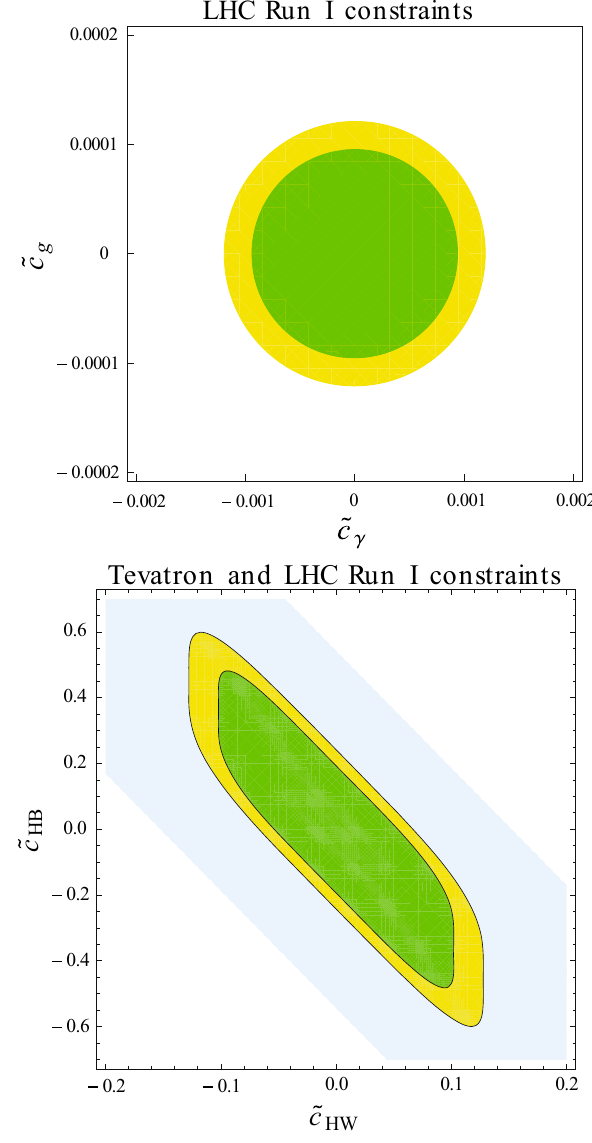
Fig. 2 Collider bounds on several of the effective operators consid- ered in the Lagrangian of Eq. (2). We show parameter space regions in agreement with LHC Run I data in the ( ˜ c γ , ˜ c g ) (left) and ( ˜ c HW , ˜ c HB ) (right) plane at the 1 σ (green) and 2 σ (yellow) level, and the region allowed by Tevatron data at the 95% confidence level is indicated by the blue